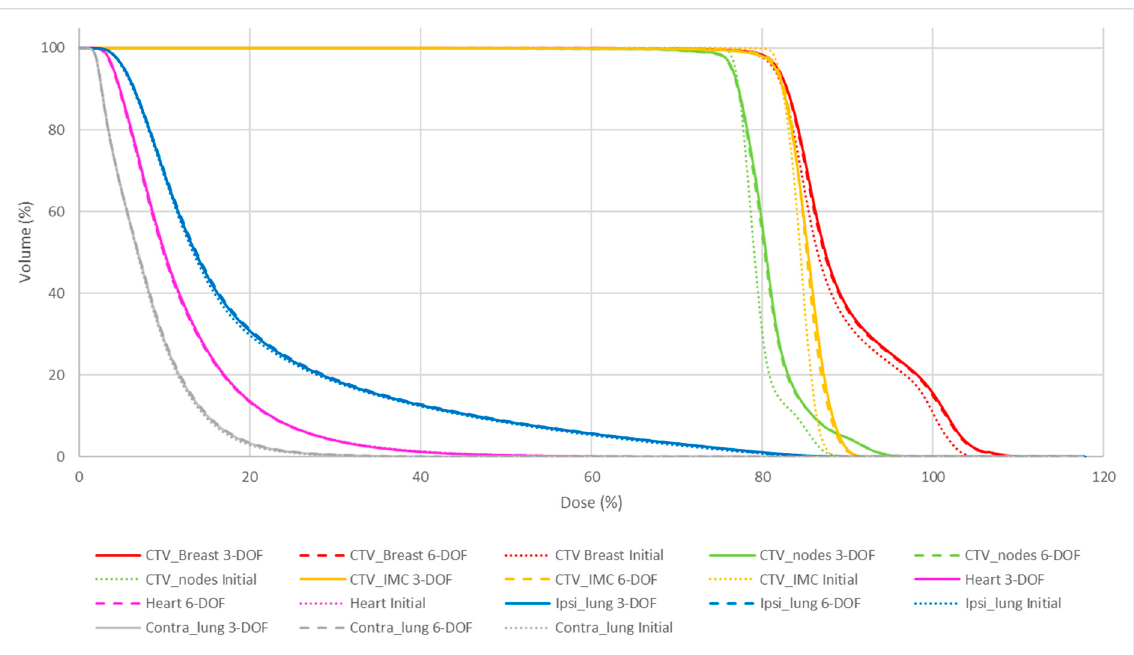
Figure 5. Dose volume histograms for the initial plan (dotted lines), 6-DOF (dashed lines), and 3-DOF (solid lines) CBCT plans for breast irradiation. N.B. The breast CTV includes the tumor bed (100% of the prescribed dose), which was not evaluated in this study.